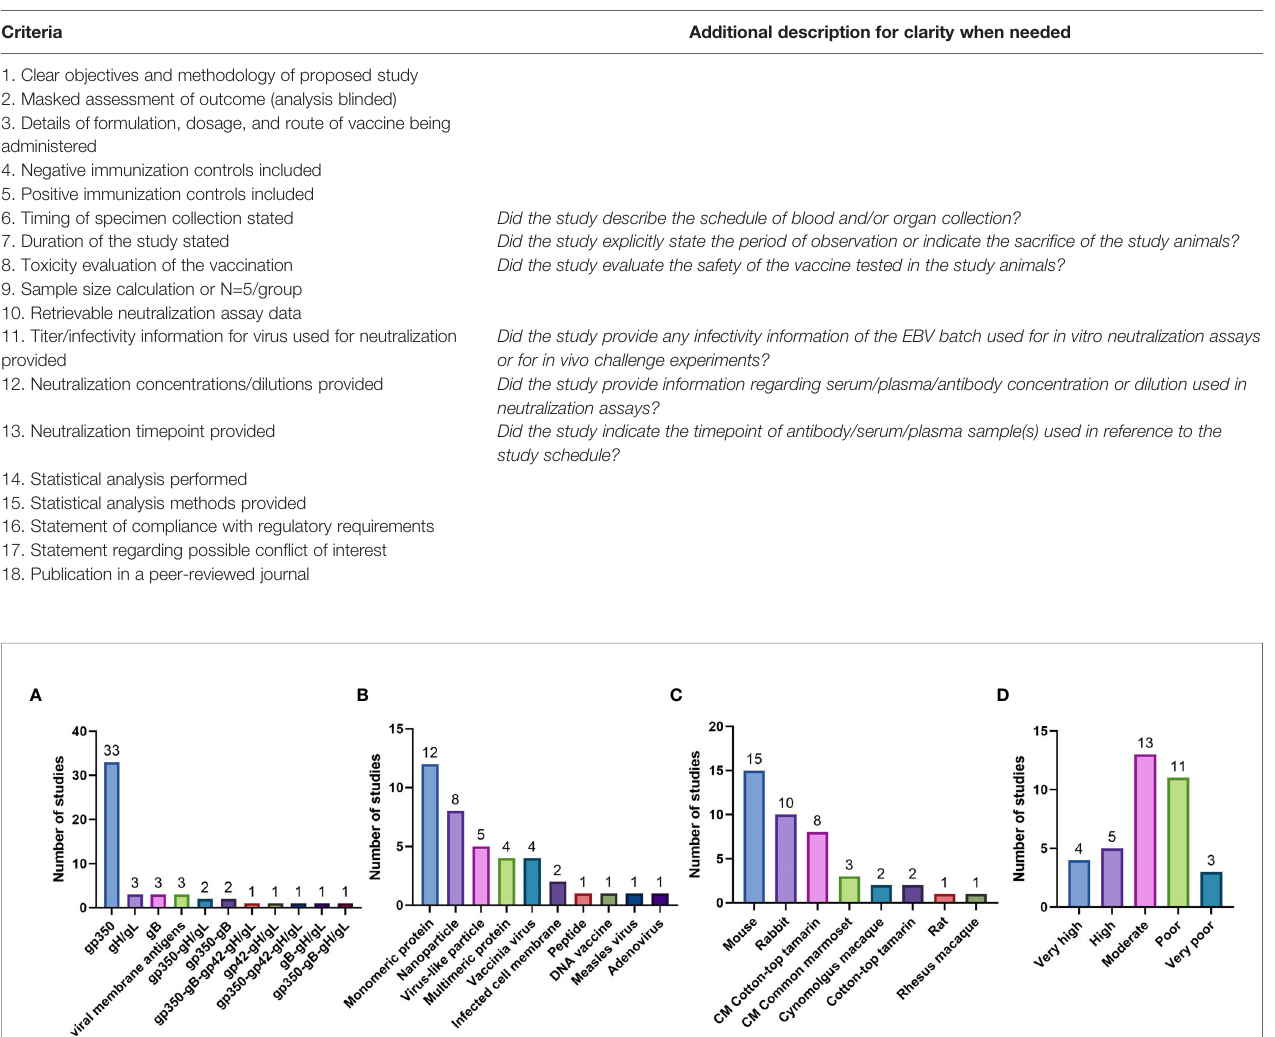
TABLE 5 | Quality assessment checklist.